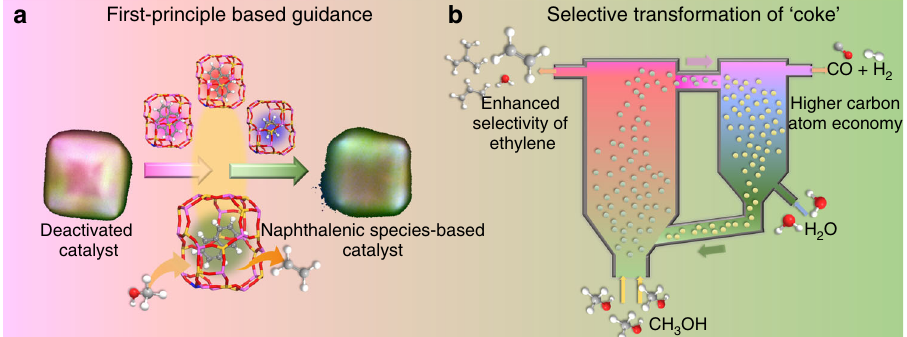
Fig. 1 Schematic illustrations of selective transformation of coke into speci fi c intermediates. a First-principle-based simulations provide the criteria of stability and functionality of organic intermediates con fi ned in nano-cavity. b Selective transformation of coke into speci fi c naphthalenic species-rich catalyst, and improvement of MTO performance and atom economy implemented in the circulating fl uidized bed reactor-regenerator con fi